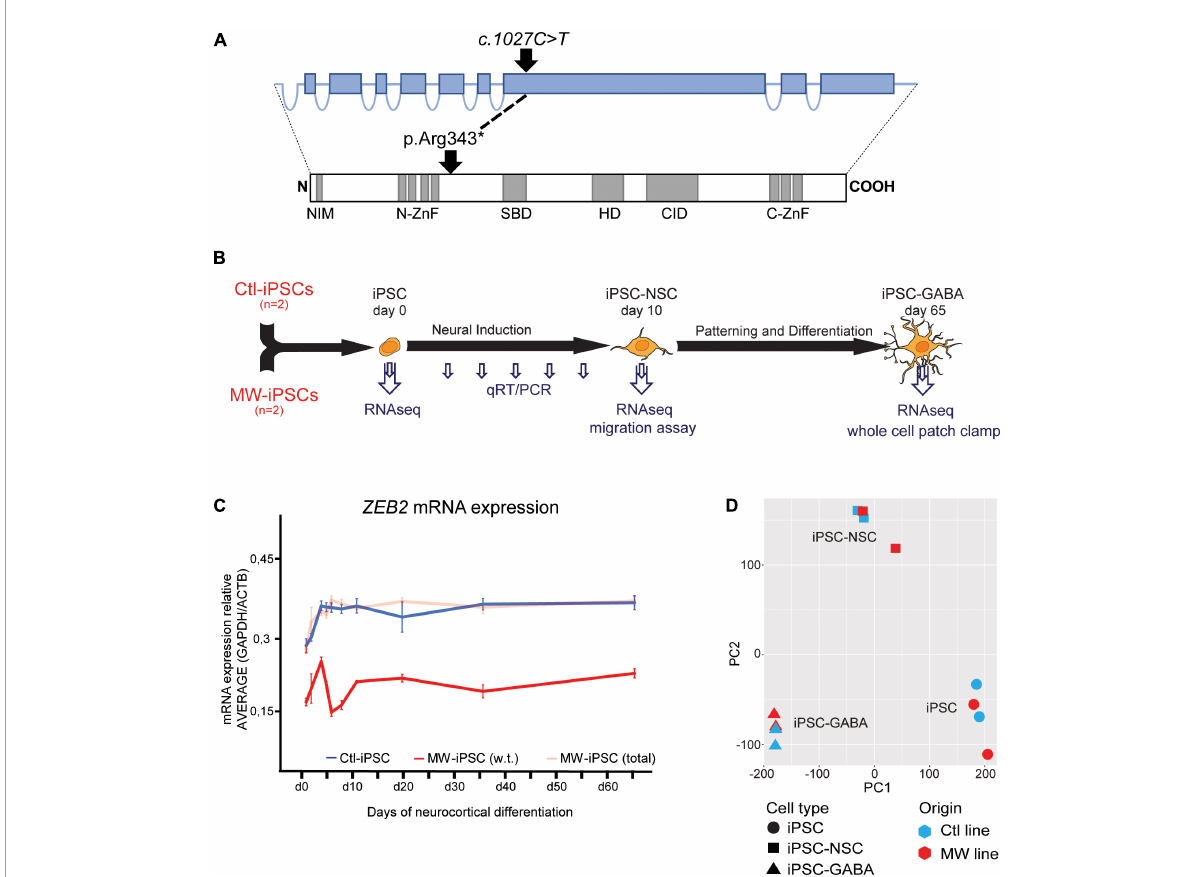
FIGURE1 (A) Schematic illustration of the ZEB2 gene structure with relative sizes of coding exons (top, blue boxes) and the corresponding ZEB2 protein architecture (bottom). The positions of the ZEB2 gene variant and the resulting predicted stop-codon are shown with relation to functional protein domains (gray boxes). NIM, NuRD interacting motif; N-ZnF, N-terminal zink-finger clusters; SBD, Smad-binding domain; HD, Homeodomain-like domain; CID, CtBP-interacting domain; C-ZnF, C-terminal zink-finger clusters (modified from Birkhoff et al., 2021). (B) Schematic presentation of the iPSC differentiation procedure and time points of analysis using different methodologies. Induced pluripotent stem cells (iPSC) from two healthy donors (Ctl-iPSCs) and two MWS patients (MW-iPSCs) were harvested for qRT-PCR at d 0, 3, 4, 5, 7, 10, 19, 35, and 65 (small arrows) and for RNA-sequencing at days 0, 10 and 65 (large arrows). Migratory capacity was assessed on confluent iPSC-NSCs at d 10 and electrophysiological activity was investigated on iPSC-GABA after d 65. (C) ZEB2 expression levels quantified by qRT-PCR during